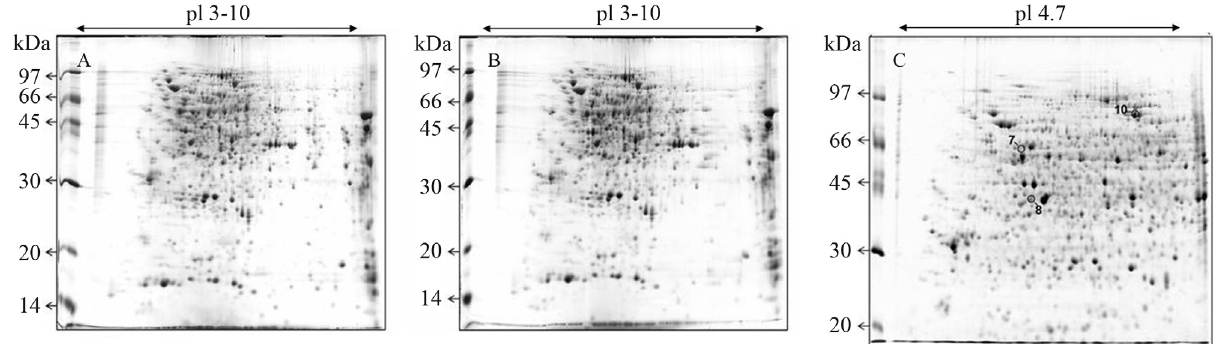
Figure2 -2-DEanalysisfromsoybeanrootproteinsextractedusingthemodifiedphenol/SDSextractionmethod(A,C)andoriginalphenol/SDSmethod (B) (Wang et al. , 2006). Solubilized proteins (350 (cid:3) g) were focalized using IPG strips (13 cm) with a linear pH range 3-10 (A, B) or a linear pH range 4-7 (C). SDS-PAGE was performed in a vertical 11.6% acrylamide gel and stained with CBB R 350. The molecular weight of protein standards is indicated on the